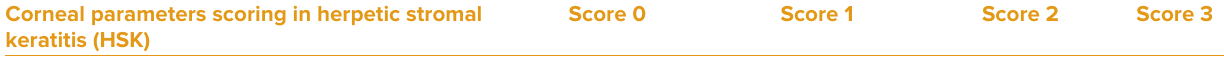
Table 1. The grading scores for the corneal parameters in herpetic stromal keratitis (HSK) Corneal parameters scoring in herpetic stromal